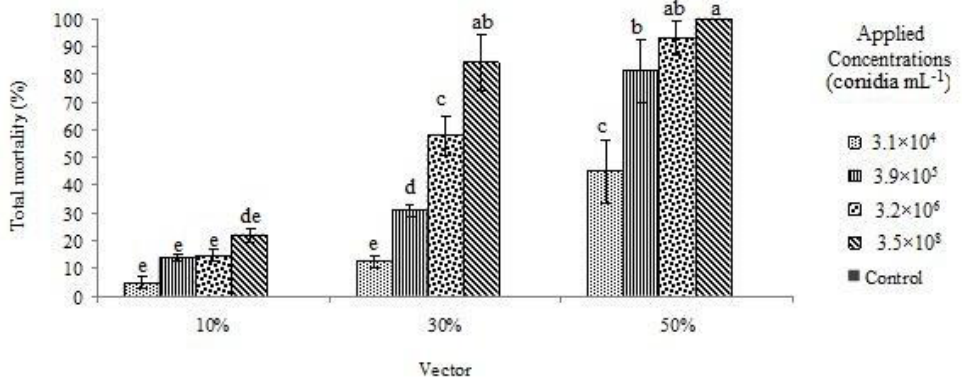
Figure 2. The level of total mortality for different treatment combinations after 14